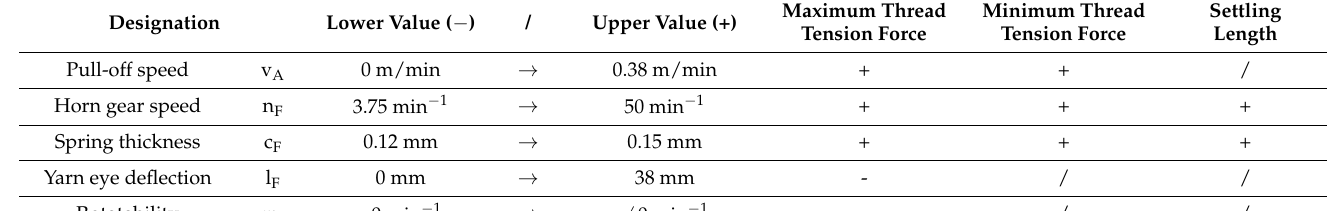
Table 2. Characteristics and the effect of the variables of the factor test space.